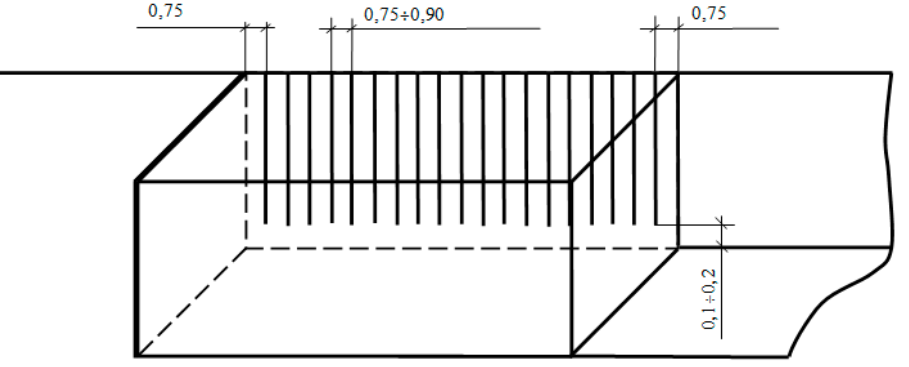
Figure 4. Diagram of hole spacing when mining aggregate material (Adapted from [16]).